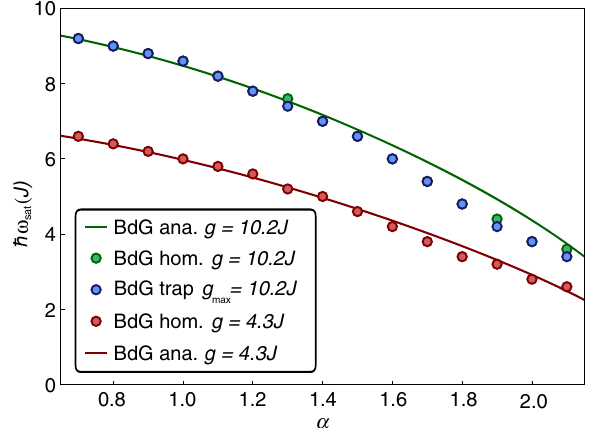
FIG. 7. Numerical simulation of the saturation frequency ω sat versus α (dots) compared to the BdG prediction (solid line) from Eq. (B1). The presence of a harmonic trap does not affect the saturation frequency significantly. A slight deviation from the BdG prediction is observed compared to the numerical simulation for large values of α ∼ 2 and sufficiently strong effective ¼ 0 . 26 J= ℏ , the interaction g=J . The trapping frequency is ω x ¼ 201 d , and the atom number is N ¼ 1000 . system size is L 0 x